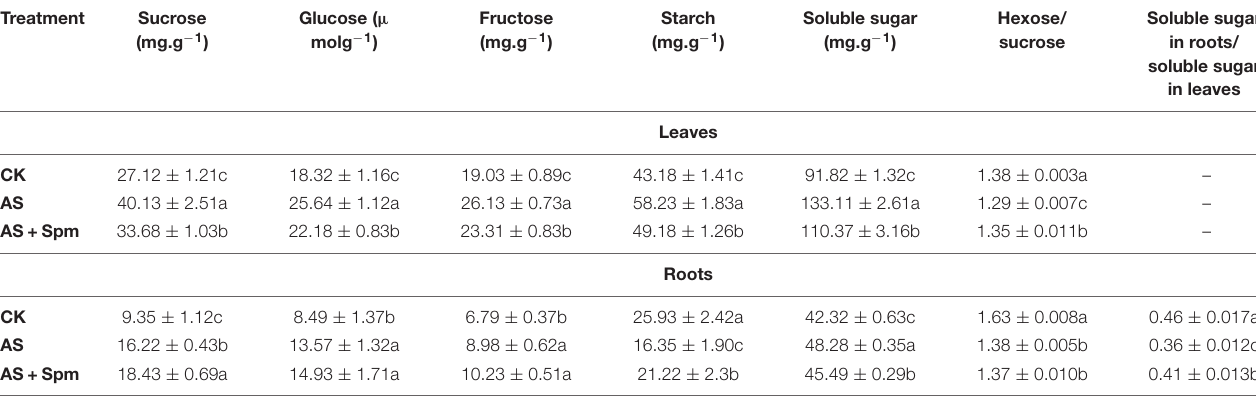
TABLE 3 | Effect of spermine application on the carbohydrate contents in leaves and roots of oats under alkali stress.